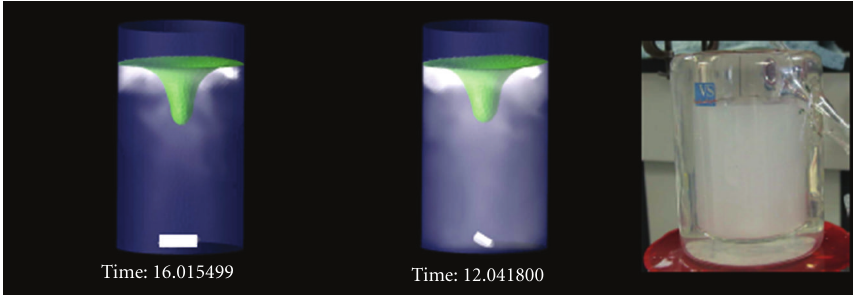
Figure 18: Tracer path-injection into the free